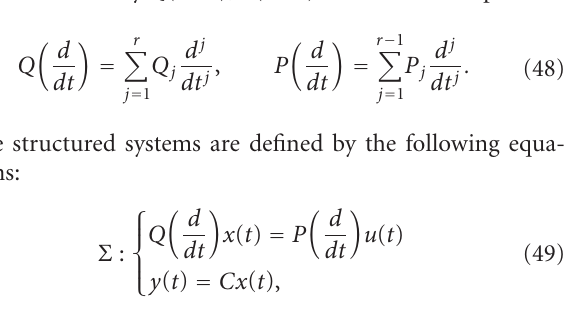
Algorithm 5 (“SVD1”), SVD method on P 11 and P 22 in Algorithm 6 (“SVD12”), balanced truncation on P 11